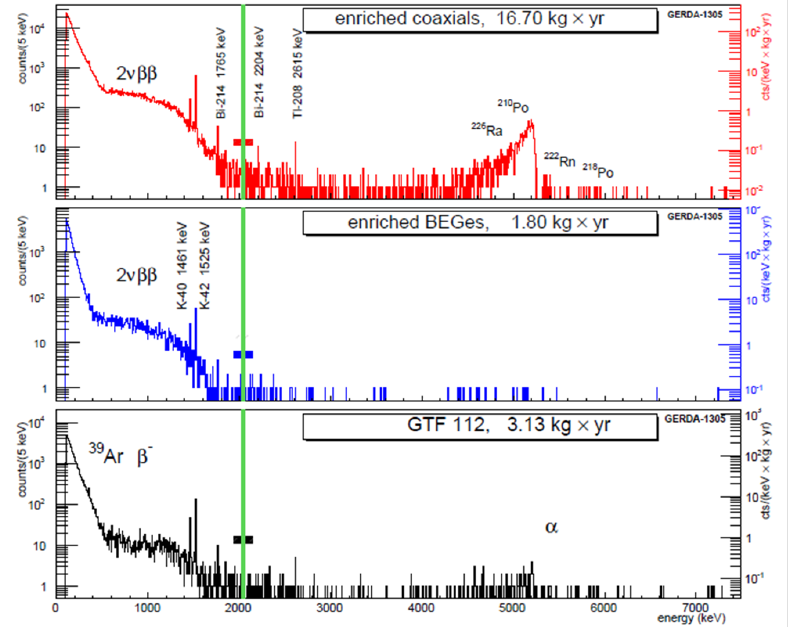
Figure 12. The blinded spectra of the three Phase I datasets. The prominent structures are labeled. The green bands identify the blinded 40 keV region around the Q ββ